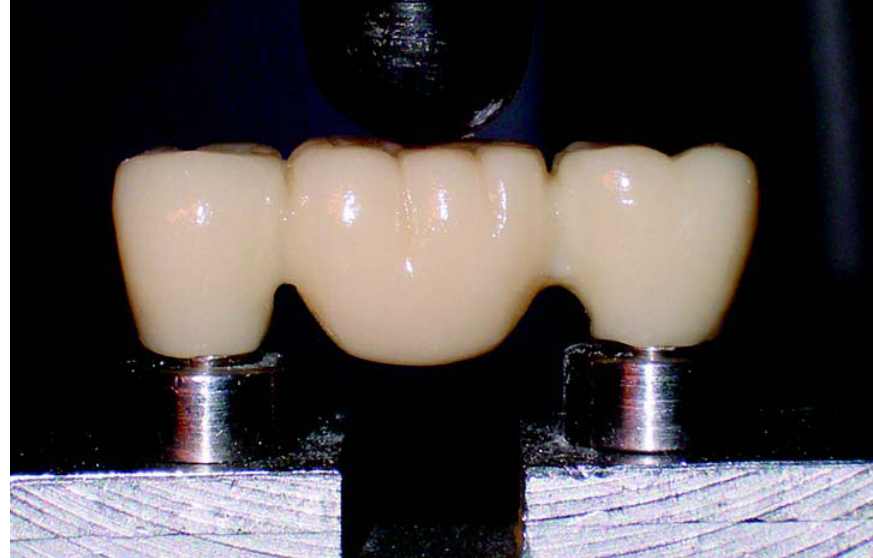
FIGURE 2- Three-unit all-ceramic fixed partial denture